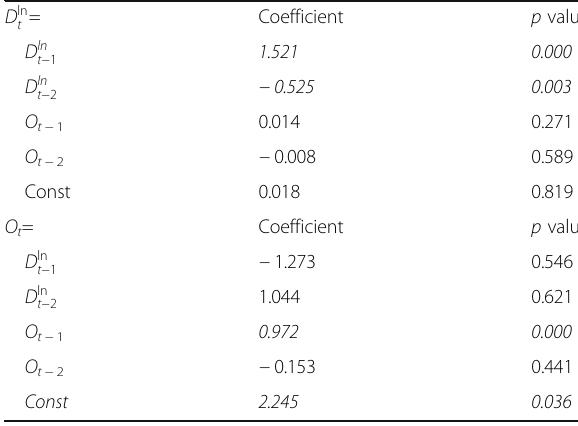
Table 7 Coefficients ’ estimations of a VAR (2) model between the D ln and O t for recession phases. Top: model for D ln t model for O t . Italics: significant results with 5%